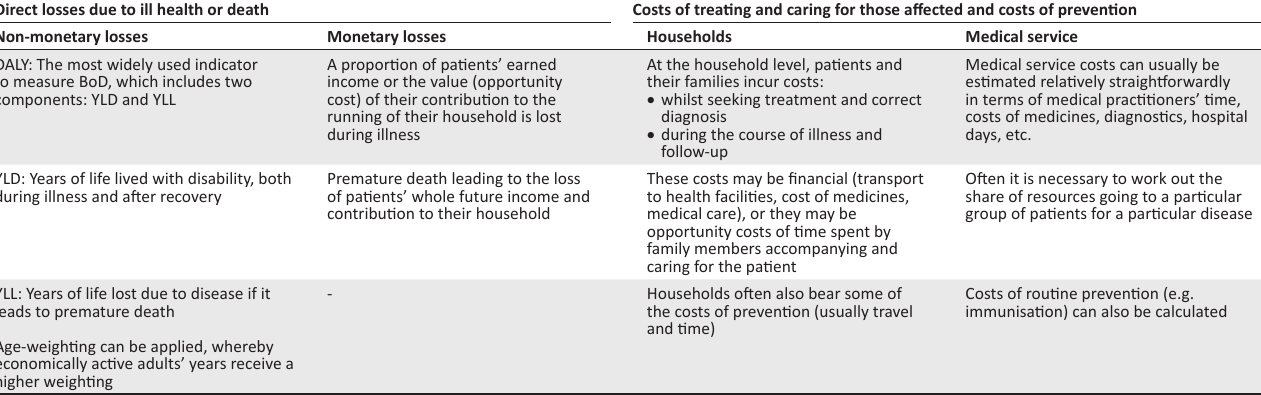
TABLE 1: Indicators for computing burden of disease in humans. Direct losses due to ill health or death Non-monetary losses Monetary losses